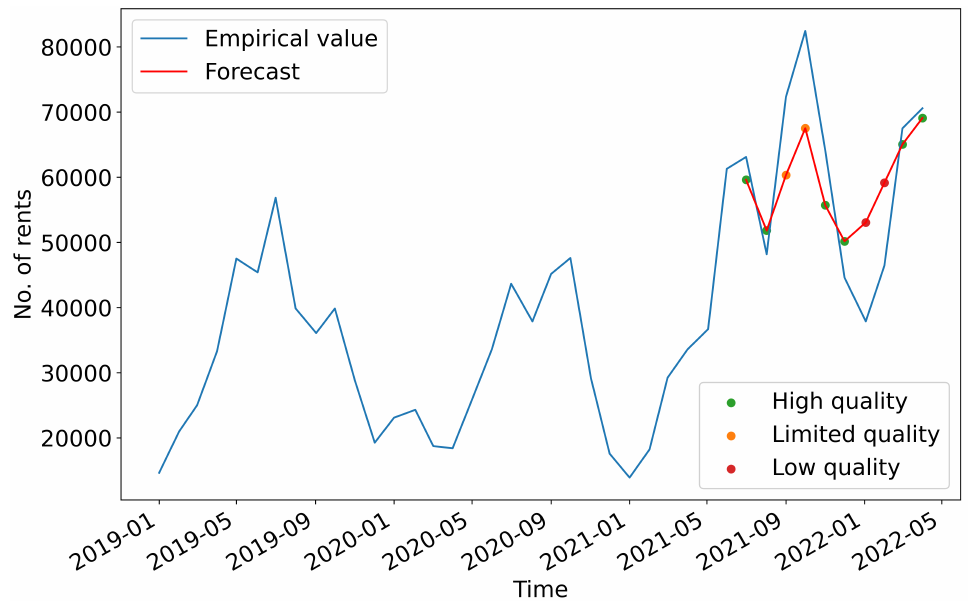
Figure 5. Mapped forecast quality to forecast data points. See Figure 6 for the rating of forecasting